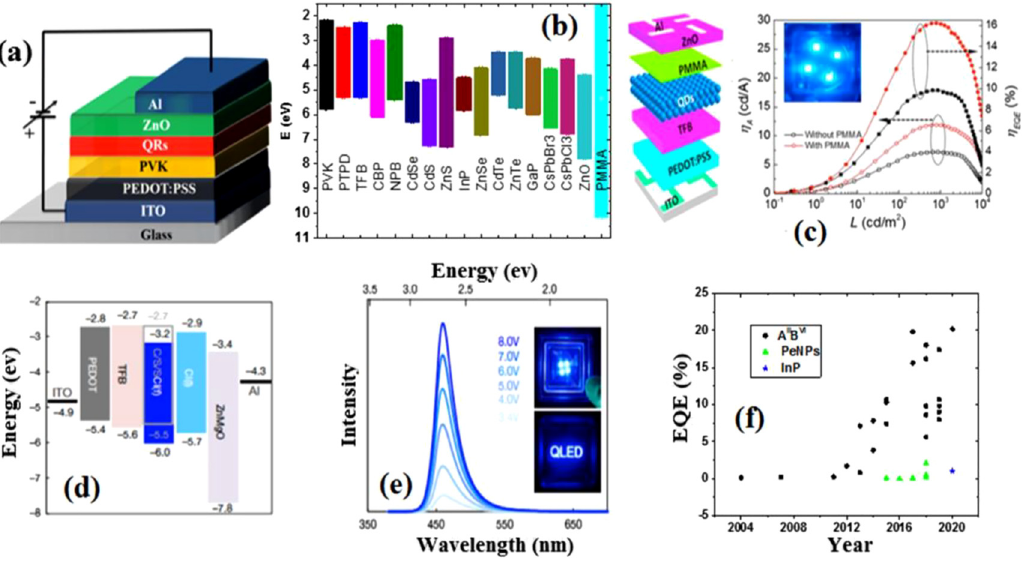
Figure 20: EL application of the blue particle. (a) Configuration of QR/QD LED; (b) Energy level of common hole- and electron- transport layers as well as emitting materials; (c) Efficiency of blue QDLED with introduced PMMA layer [95]; (d,e) Architecture, EL spectra and photo of QDLED from [205]; (f) EQE of reported QDLEDs based on A II B VI , InP and perovskite NPs by